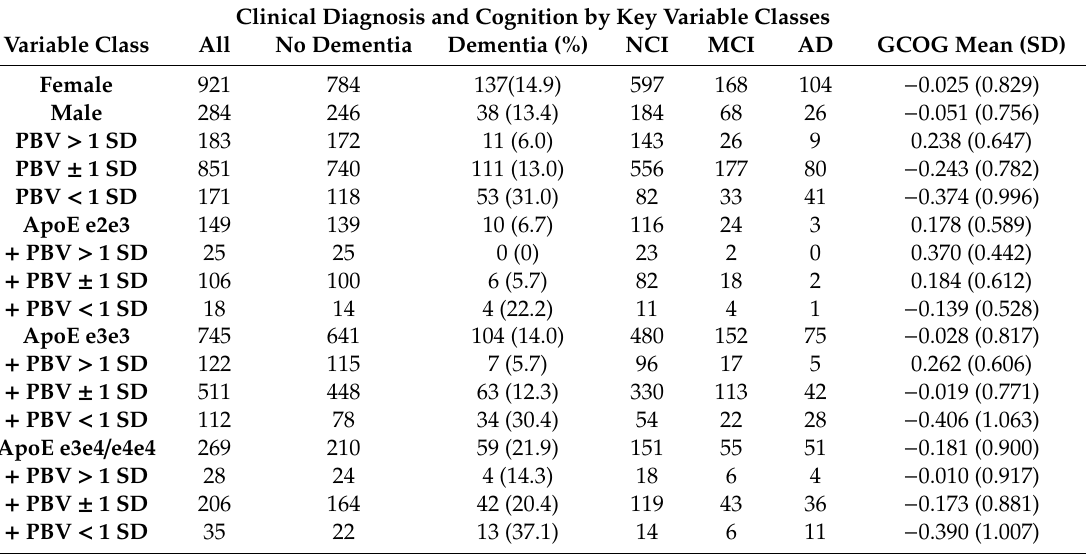
Table 2. Clinical diagnoses and global cognition in key variable classes. Clinical Diagnosis and Cognition by Key Variable